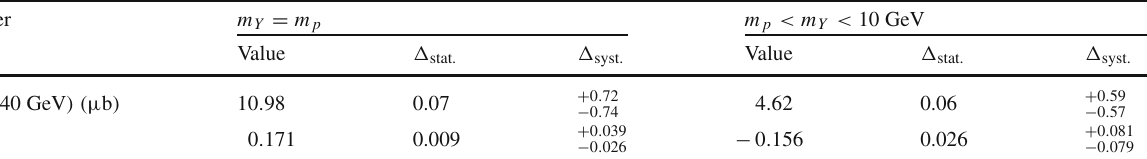
fit values and statistical and systematic uncertainties are given. A full uncertainty breakdown and statistical correlations are provided [77].